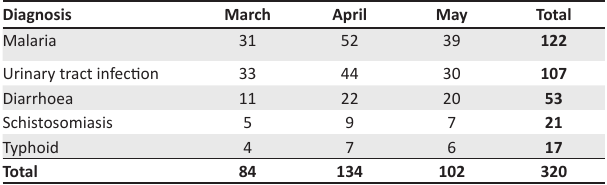
TABLE 2: Trends in selected water-related diseases (March–May, 2009).